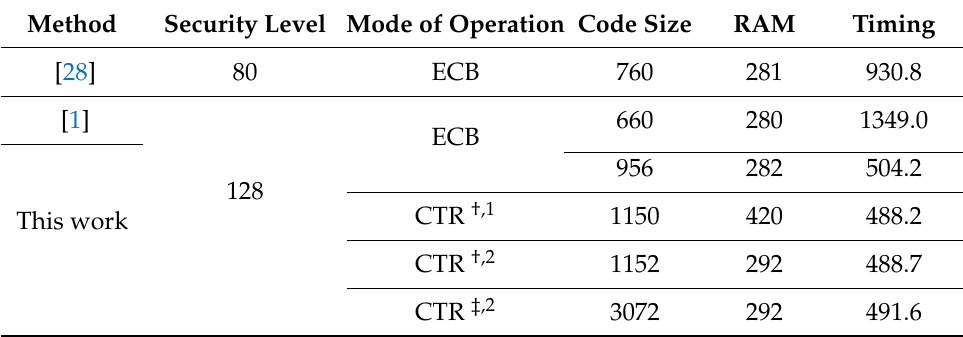
Table 1. Comparison of PRESENT on target embedded processors (Alf and Vegard’s RISC (AVR)) in terms of timing (cycles per byte), RAM (bytes), and code size (bytes), 1 : Pre-computation in RAM, 2 : Pre-computation in ROM, † : 16-bit counter, ‡ : 32-bit counter. ECB: Electronic Code